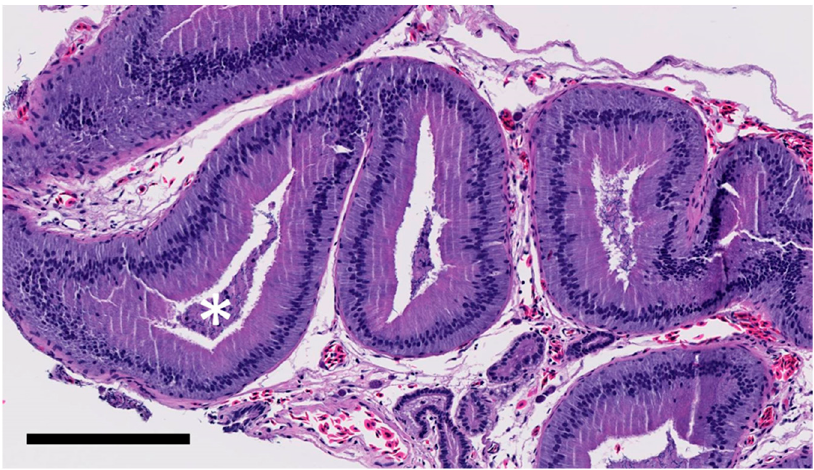
Figure 6. Few mature spermatozoa (white asterisk; grade 1/3) in epididymis of gecko receiving saline. Bar = 200 µm.